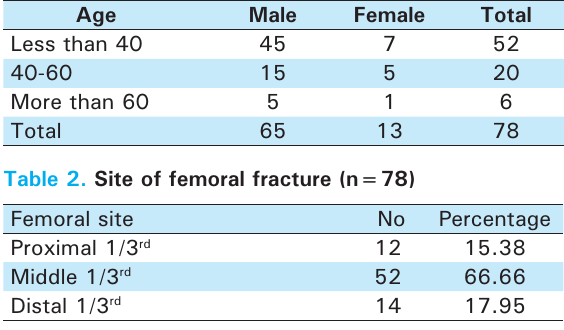
Table 3. Percentage of cases who had unions, malunions,